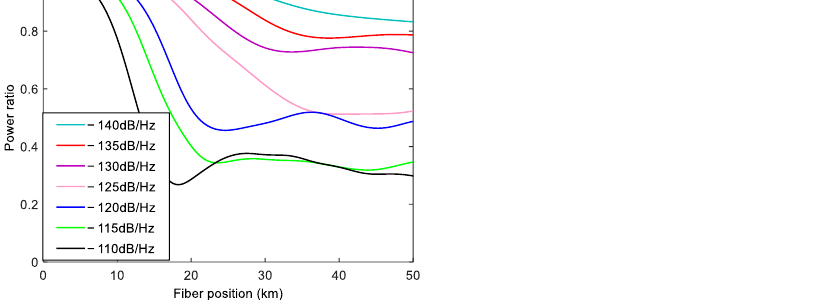
Figure 2. The relationship of R versus the transmission distance with different ASE noise levels.